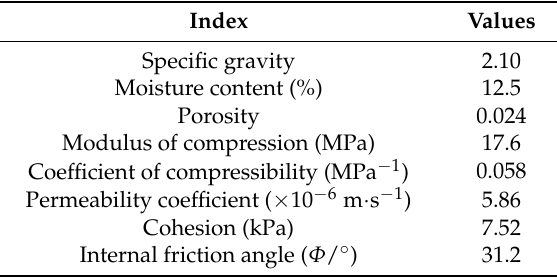
Table 2. Properties of the copper tailings sample.